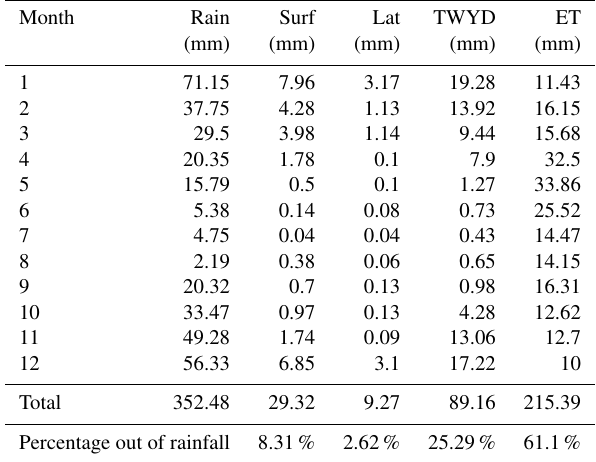
Table 3. Average of simulated monthly Water balance components of R’dom basin during the actual simulation period